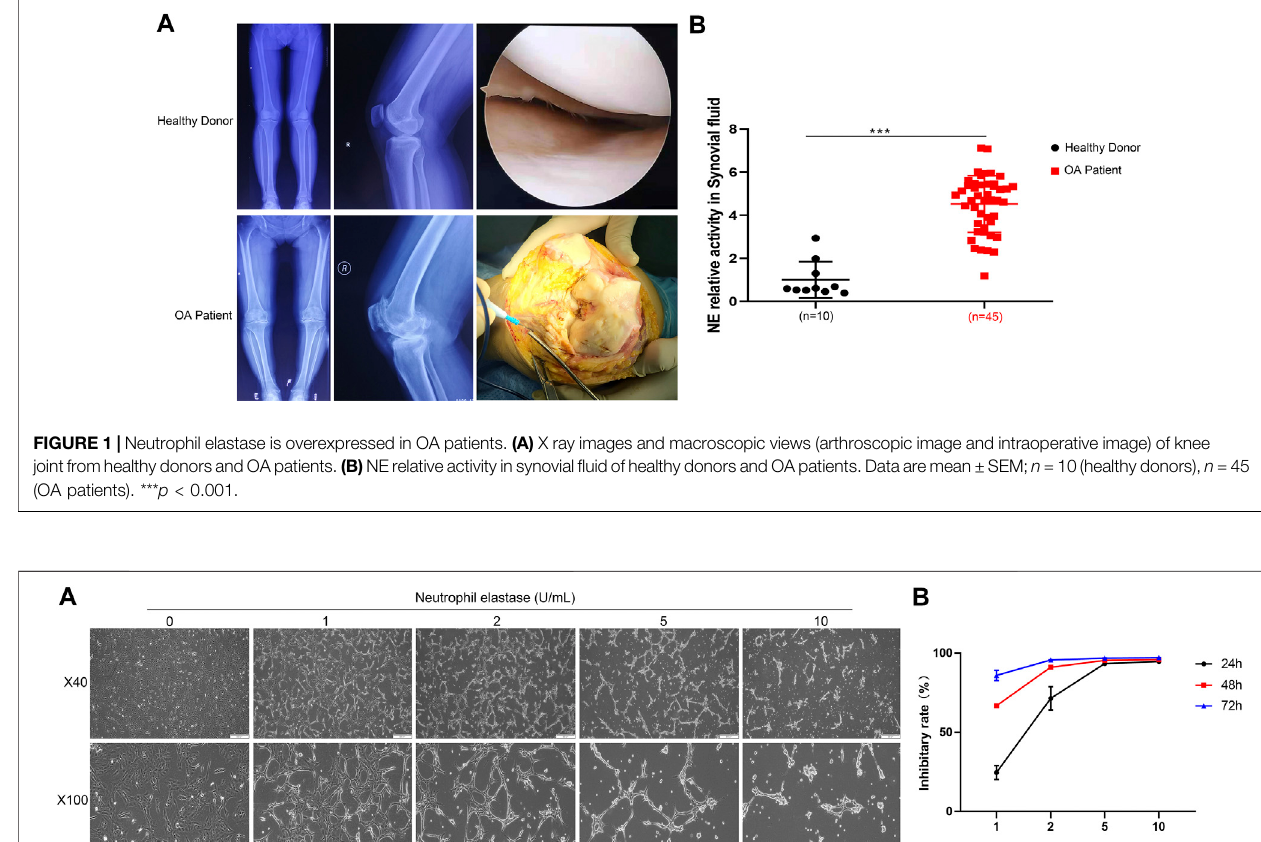
Error bars for SEM are shown. Where indicated in the fi gures, degrees of p -value signi fi cance are as follows: *p < 0.05, **p < 0.01 and ***p < 0.001.